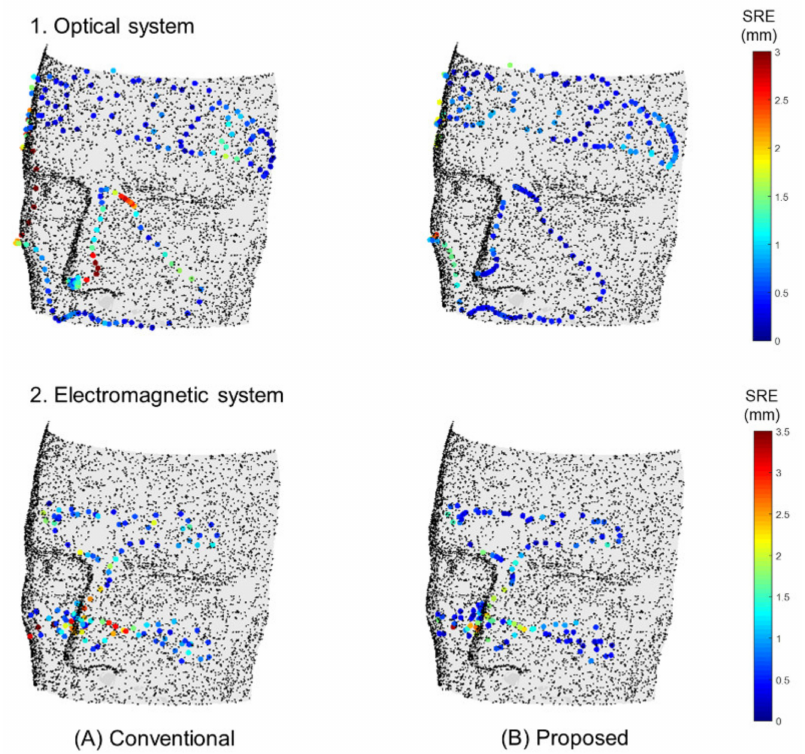
Figure 9. Visualized comparison of SRE between the conventional and proposed registration strate- gies (representative trials) ( A , B ).